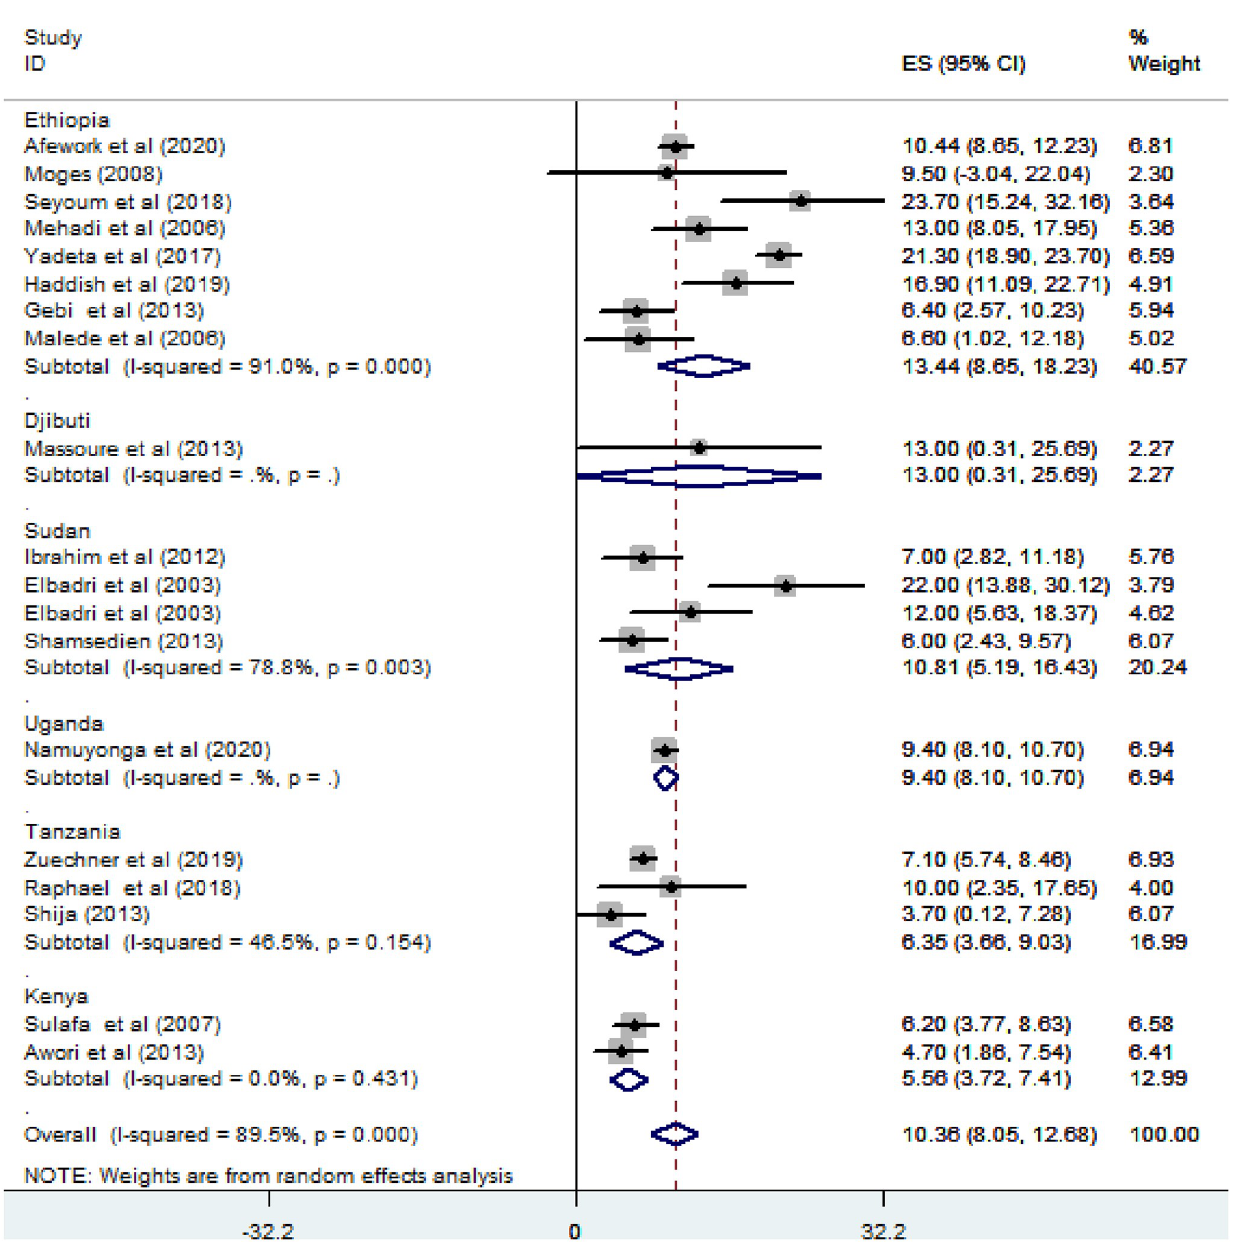
Fig 8. Forest plot showing the subgroup analysis of the prevalence of atrial septal defect among congenital heart defect patients by country in East Africa, from January 2000-October 2020.